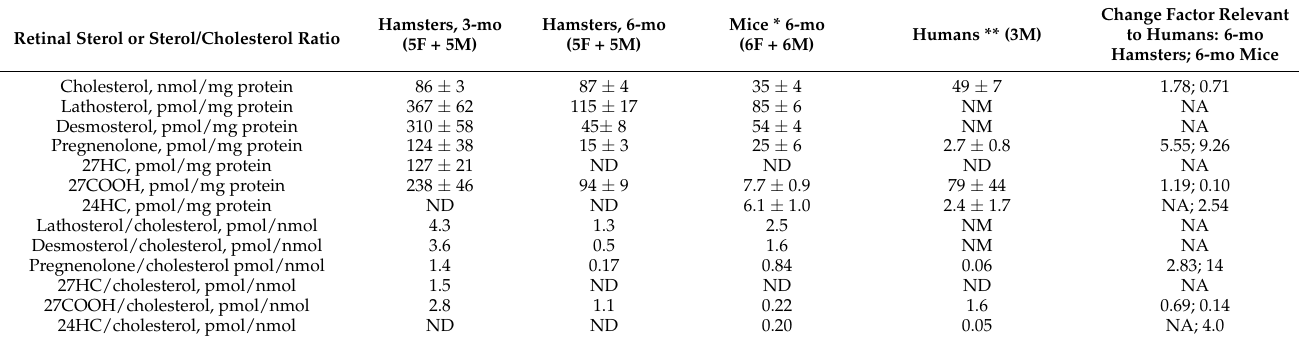
Table 2. Retinal amounts of free sterols and their relative ratios to cholesterol in different species. Numbers in parenthesis indicate the number of assessed animals or humans (F, female; M, male).